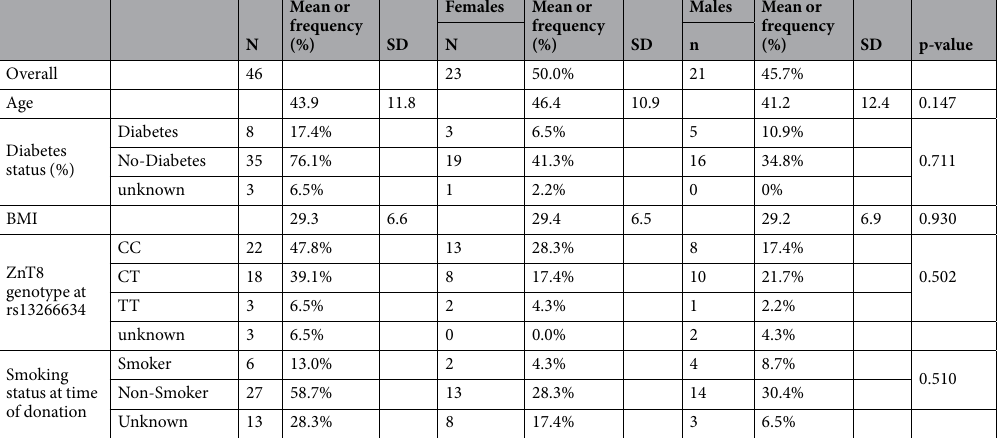
Table 1. Baseline characteristics of all participants. Differences between genders were compared using t-test for continuous variables and Chi-Squared test for categorical variables.